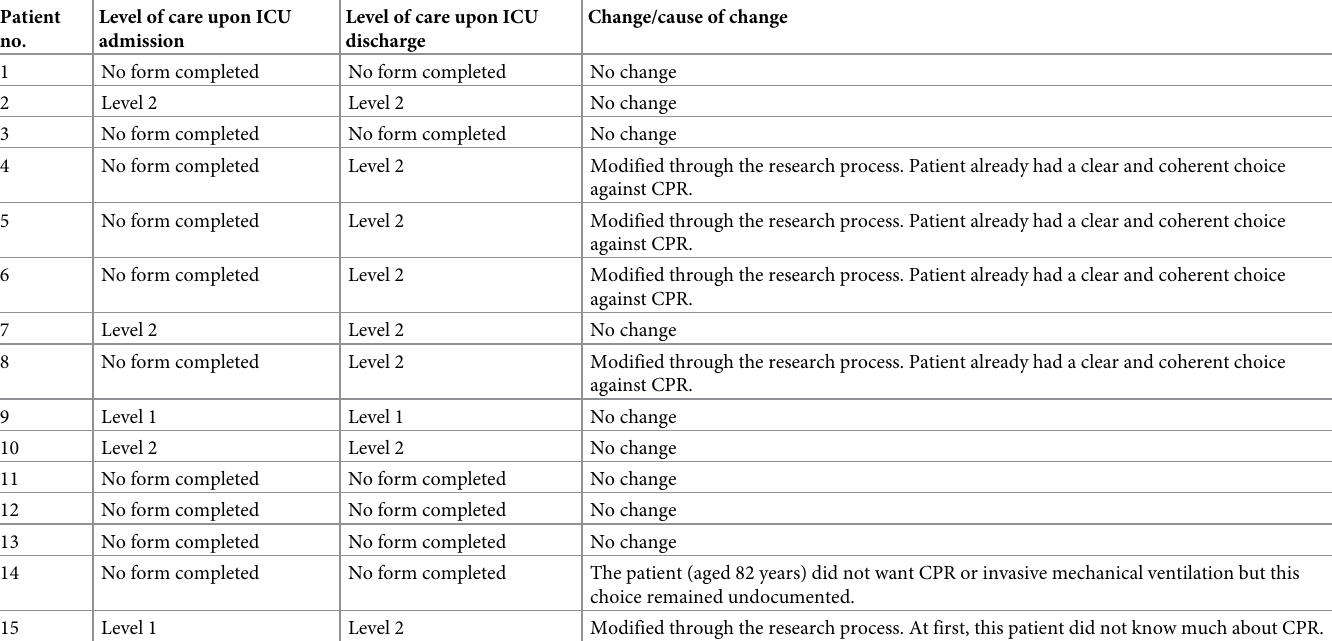
Table 5. Patients’ level of care upon ICU admission and discharge, any change and cause of change made. Patient